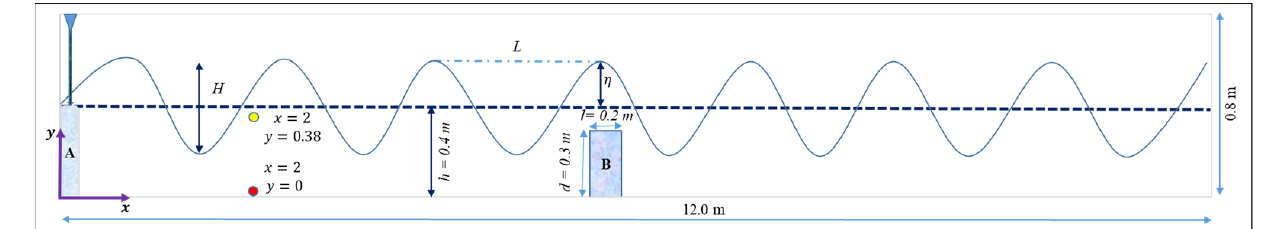
Figure 1. Schematic of computational fluid dynamics (CFD) wave flume (A: wavemaker, B: artificial reef, H : wave height, h : still water, L : wavelength, η : free surface, d : height of artificial reef, l : length of artificial reef, yellow and red circle: release locations of microplastics). The origin is located at the bottom left corner.